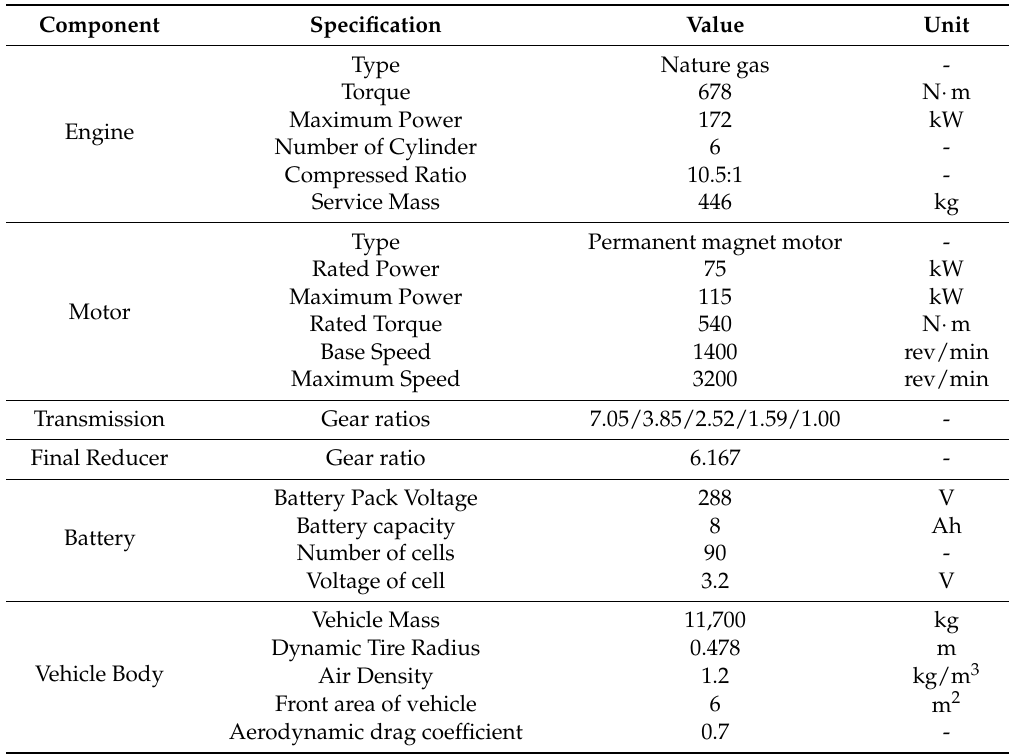
Table 3. Fuel consumption in simulation and real vehicle platform.